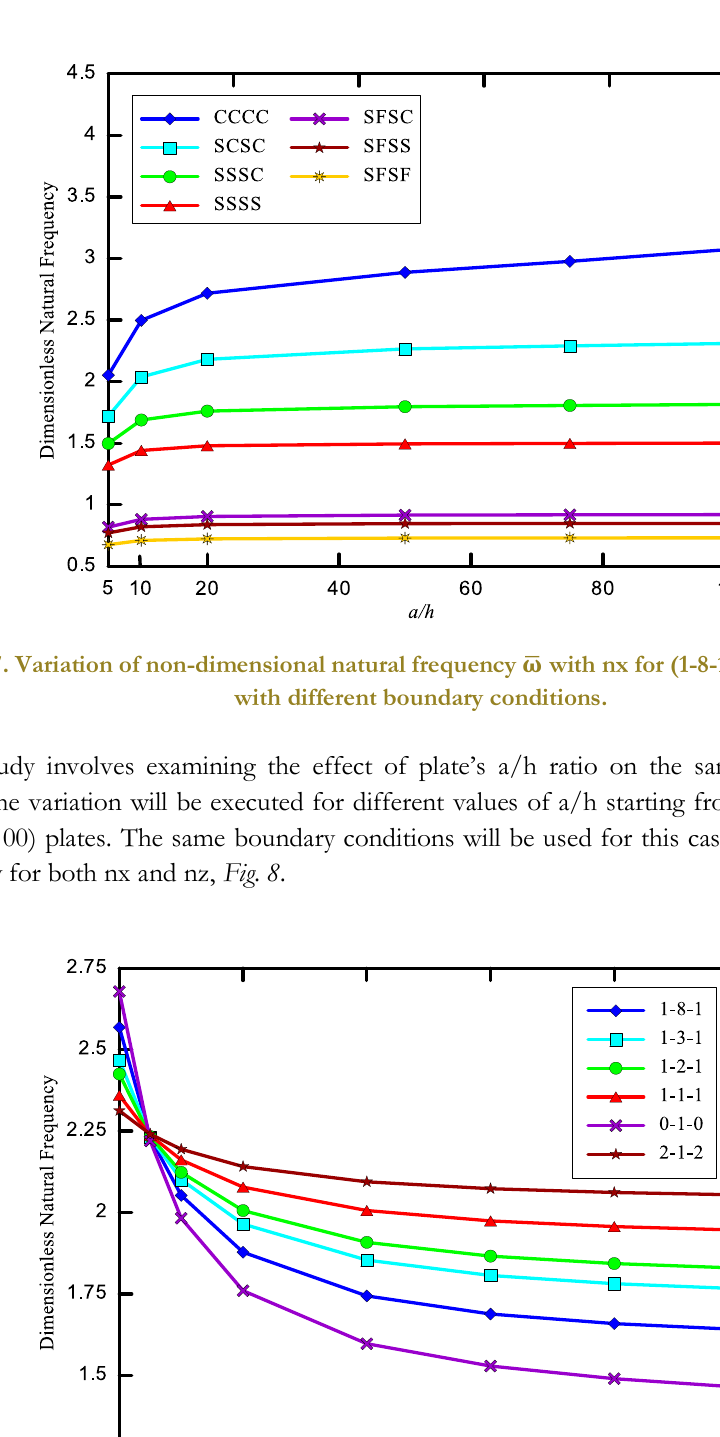
Fig. 8. Variation non-dimensional natural frequency 𝝎̅ with a/h for (1-8-1) sandwich plate with n x = n z =1 and different boundary